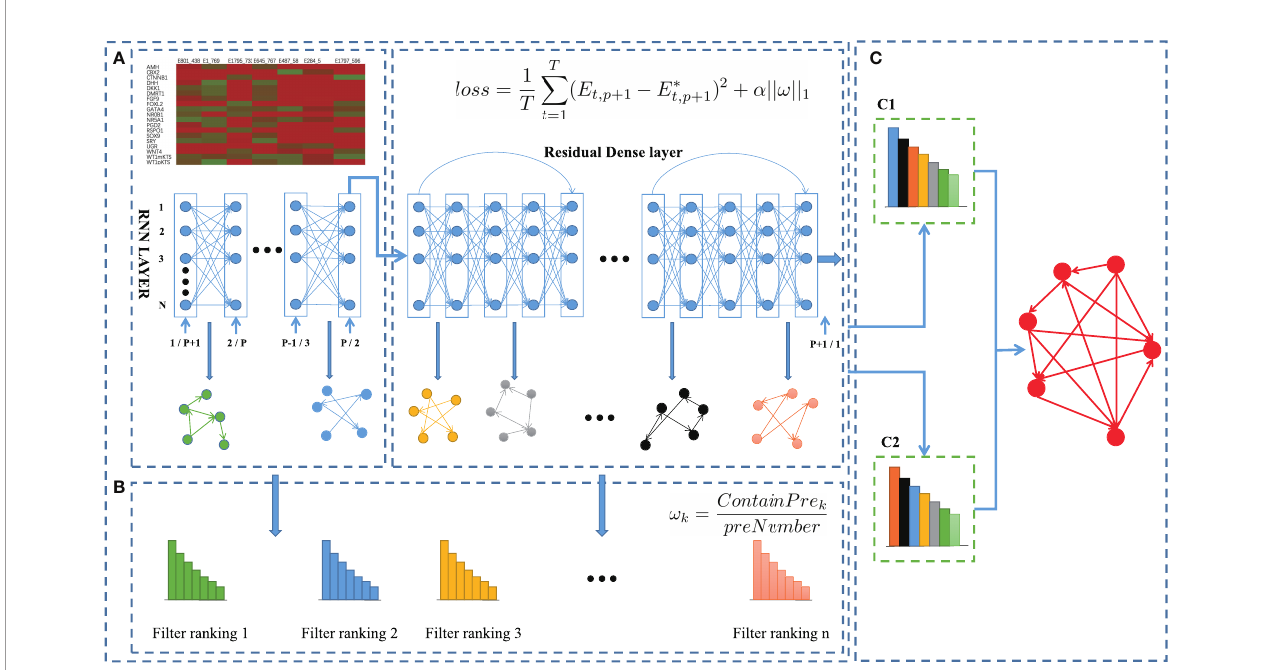
FIGURE 1 | BiRGRN reconstructs GRNs from time-series single cell transcriptome data using bidirection RNN. (A) Inferring initial gene regulatory network with RNN. (B) Incorporating incomplete prior knowledge to adjust candidate regulatory edges. (C) Adopting a voting strategy to integrate multiple candidate regulatory networks, and further utilizing bidirectional model to optimize the inferred